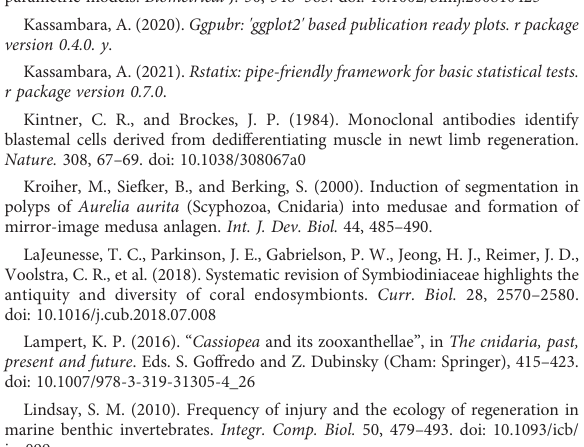
SUPPLEMENTARY TABLE 2 Regeneration Classes.